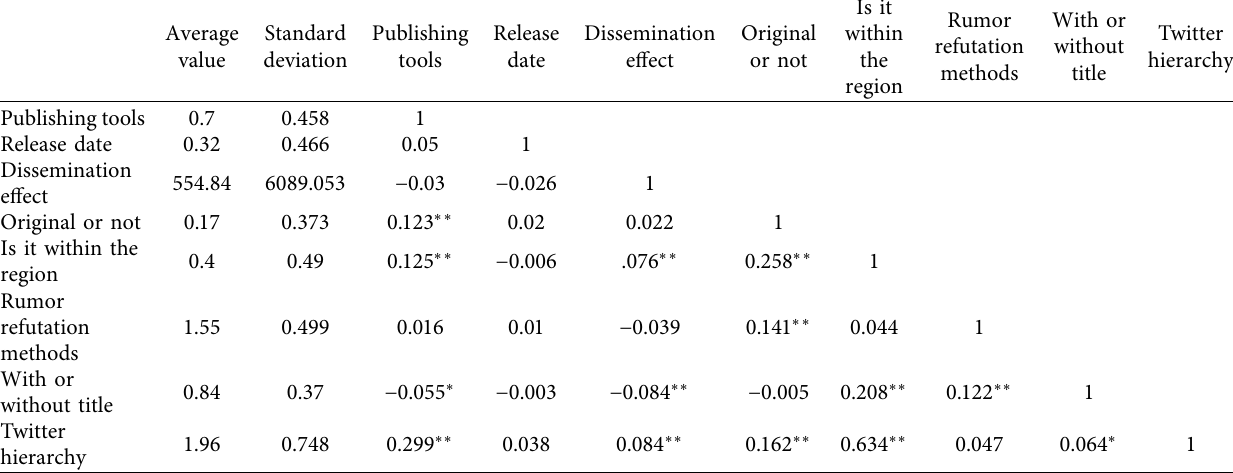
Table 2: Results of correlation